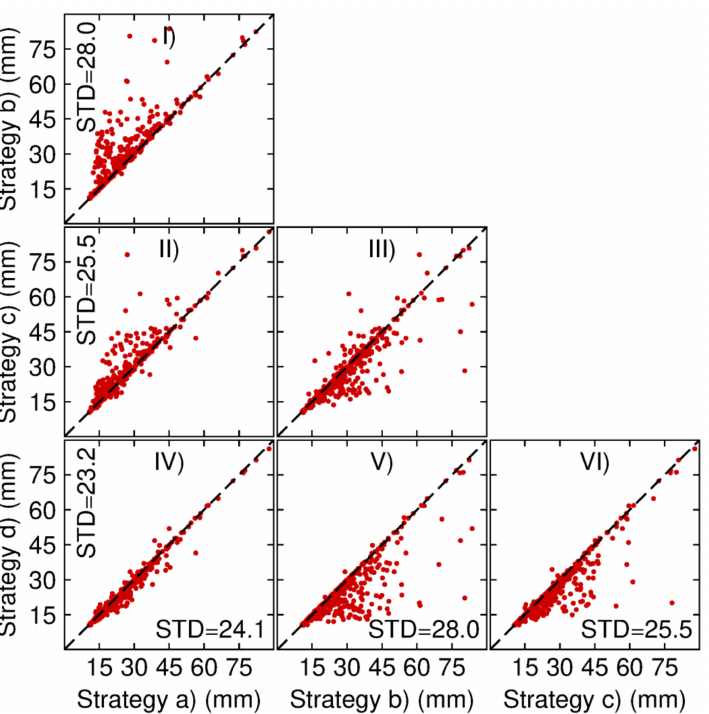
Figure 8. Ambiguity-fixed mean standard deviations of position errors comparison in the up direction between the daily kinematic PPP-AR solutions based on strategies (a), (b), (c) and (d). For I-VI panels, each panel denotes the comparison of two